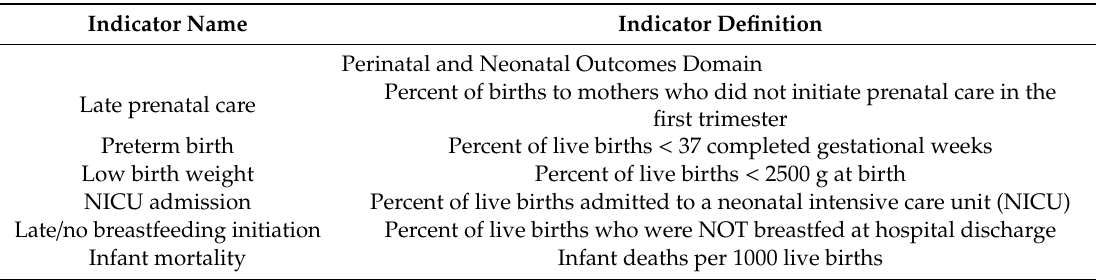
Table 1. Indicators included in the Need Indices: Metrics on Maternal and Children Health Outcomes and Structural